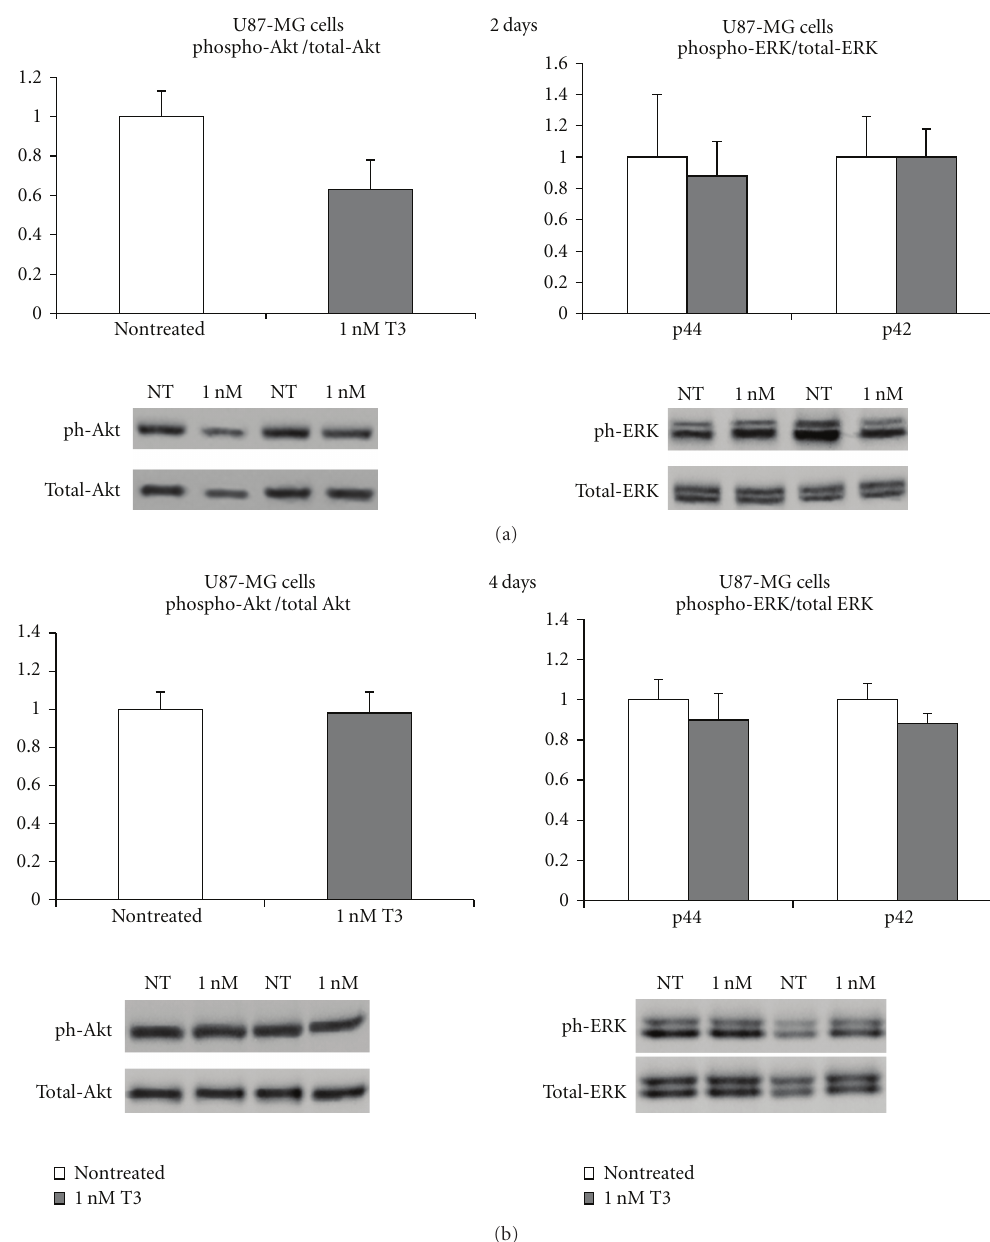
Figure 4: Phosphorylated levels of Akt and p44, p42 ERK after exposure of 1321N1 cells for 2 days (a) and 4 days (b) in 1nM T3 as compared to non treated cells. Data were derived from n = 5 samples in each group. Representative Western blotting images are shown. ∗ P < 0 . 05 versus non